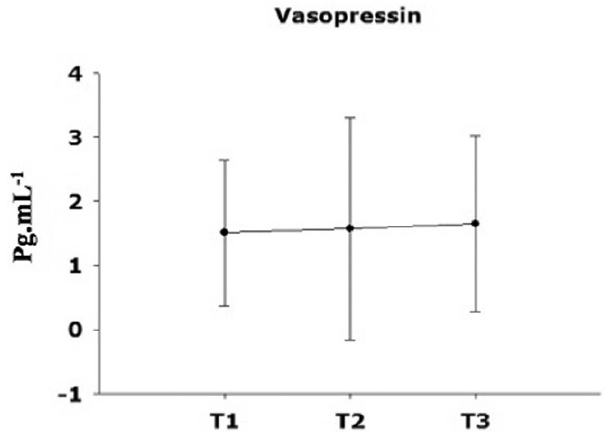
Figure 2 - Vasopressin levels (mean ¡ standard deviation) at baseline (T1), 30 minutes after abdominal insufflation (T2), and 30 minutes after the end of the pneumoperitoneum (T3).